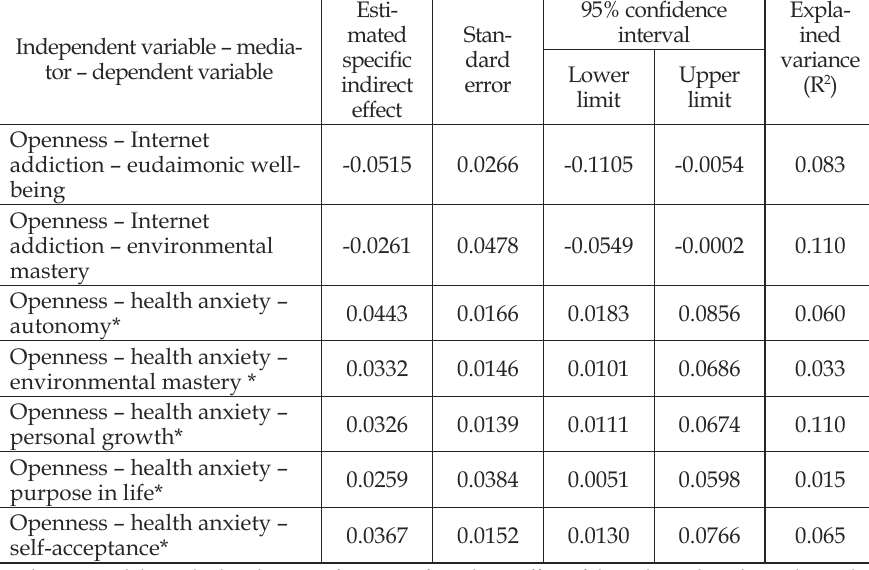
Tab. 2. Signi (cid:222) cant indirect effects with independent variable Openness and